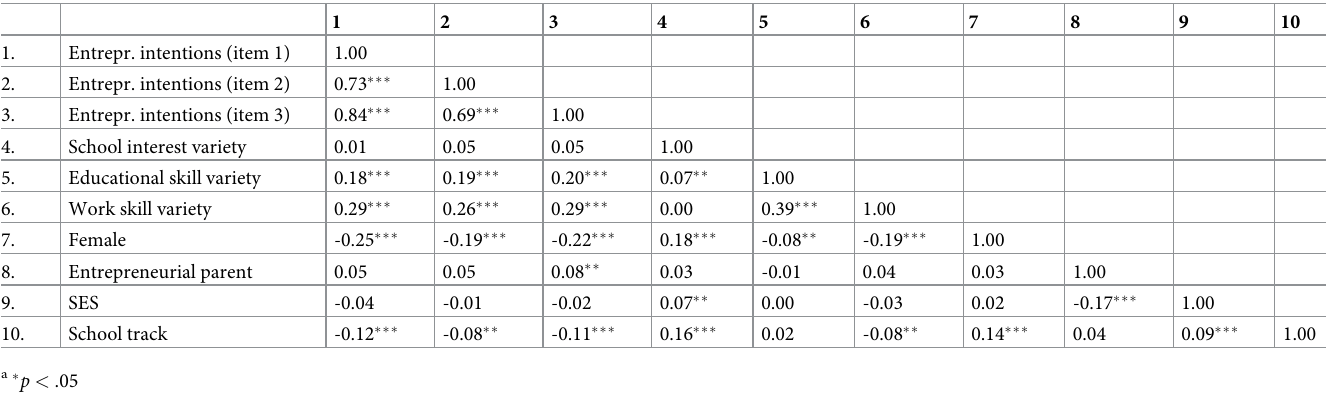
Table 2. Pearson correlations between the variables a